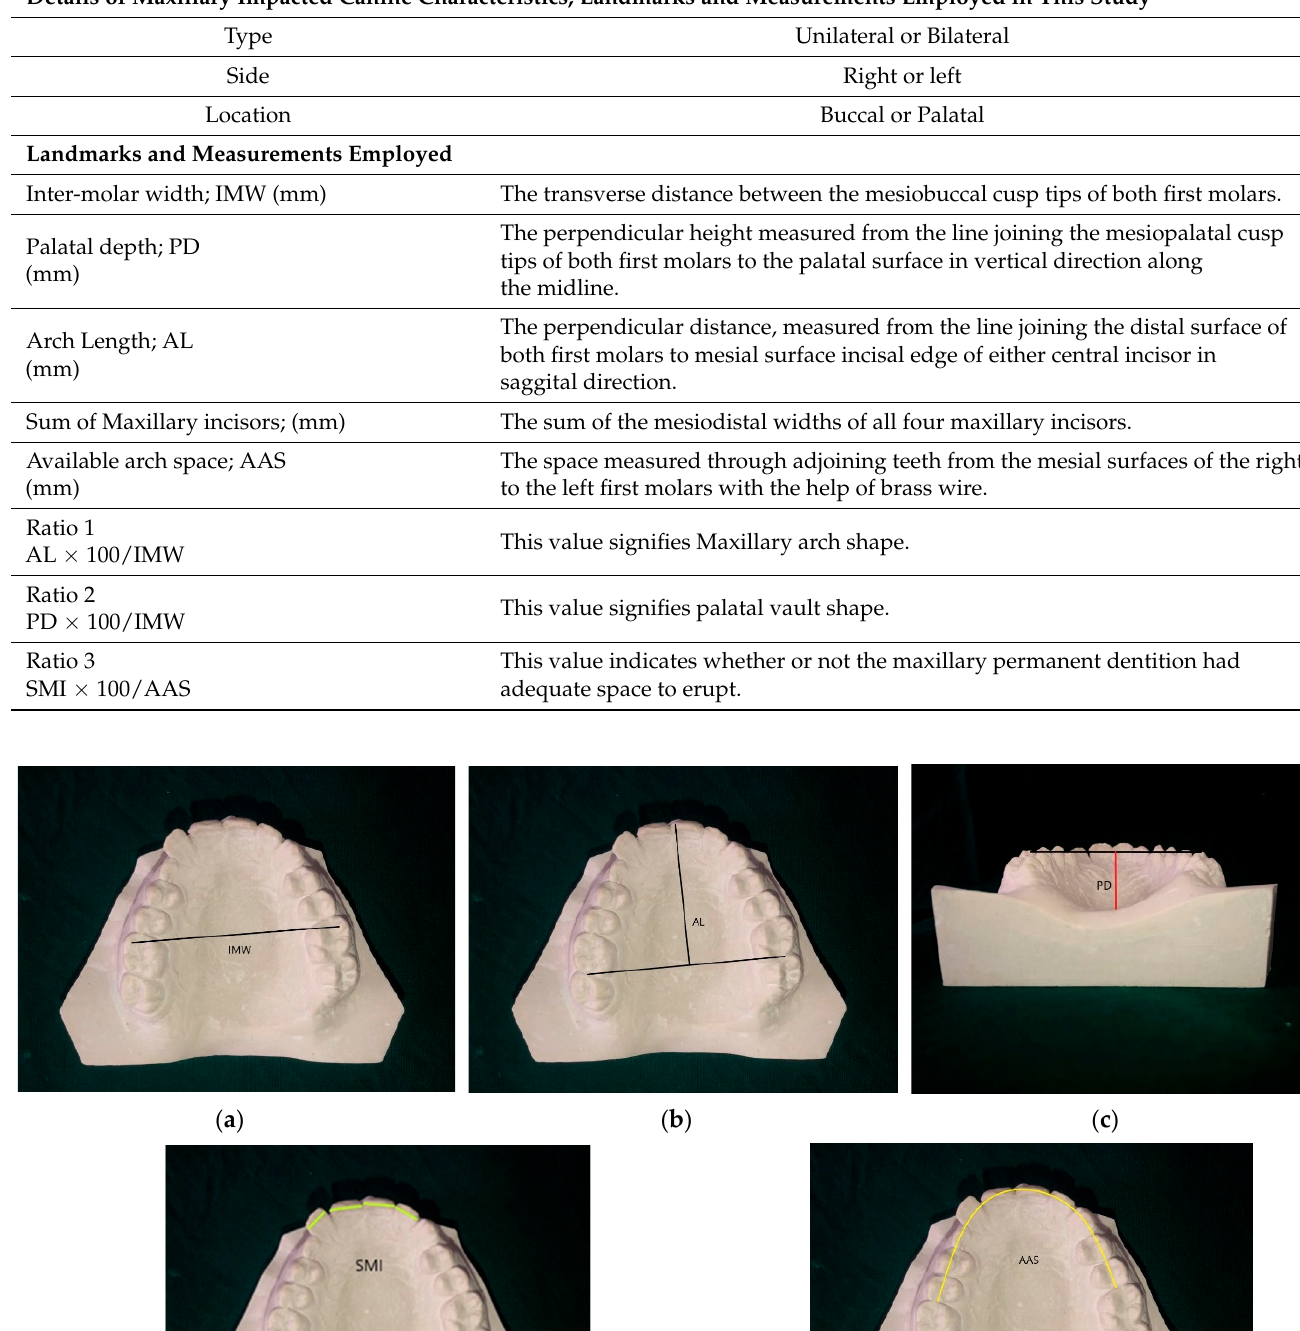
Table 1. Maxillary impacted canine characteristics, landmarks and measurements employed in this study as described by Kim et al. [24].